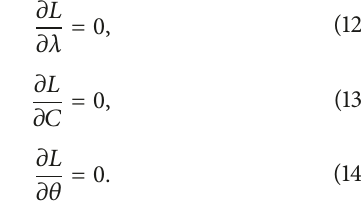
𝐶 𝑛 𝑢 𝑛 𝑖,𝑗,𝑘 , 𝑖+1/2,𝑗,𝑘 ,